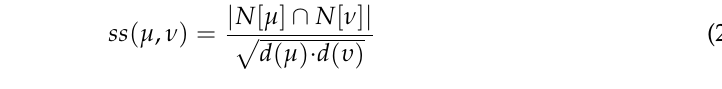
Figure 1. Core-point cluster. The color black is the core point. The current cluster range is indicated by the dashed line. The red point should be part of the current core point. The blue dot is not in the right category right now.